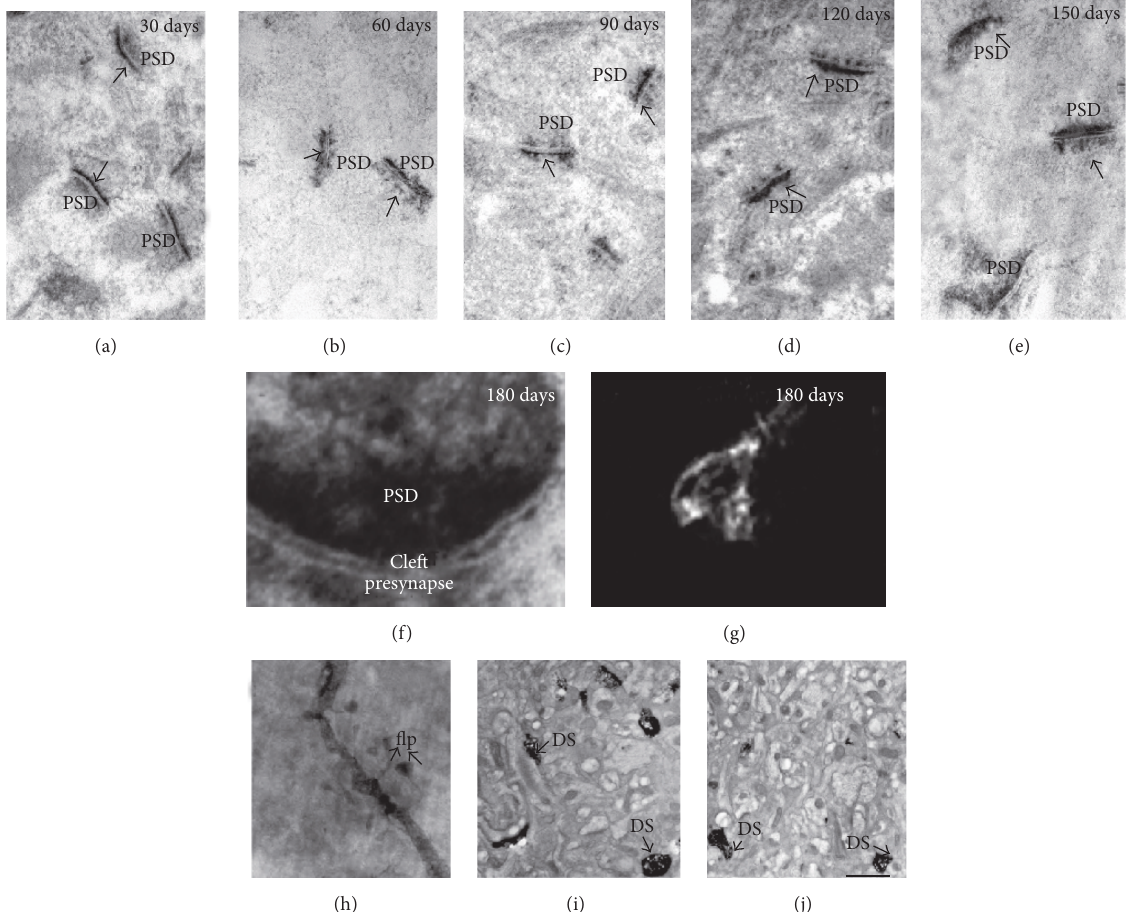
Figure 2: Microphotographs of synaptic terminals of the hippocampus CA1 area from animals subjected to PA. (a–e) Hippocampal synapses stained with E-PTA showing increased thickness in PSDs. (f) More consistent changes were observed in PSDs after 180 days of PA. Three- dimensional reconstruction of the asphyctic postsynaptic domain (g) showed clear signs of degeneration. (h) Dendritic shaft injected with Golgi silver staining showed filopodium after 30 days of PA (arrows). (i-j) DS stained with phalloidin eosin and photoconverted. A higher number of DS are observed at 30 days compared with 180 days after PA. PSDs = postsynaptic densities; E-PTA = ethanolic phosphotungstic acid; DS = dendritic spines. Scale bar 0.5 𝜇